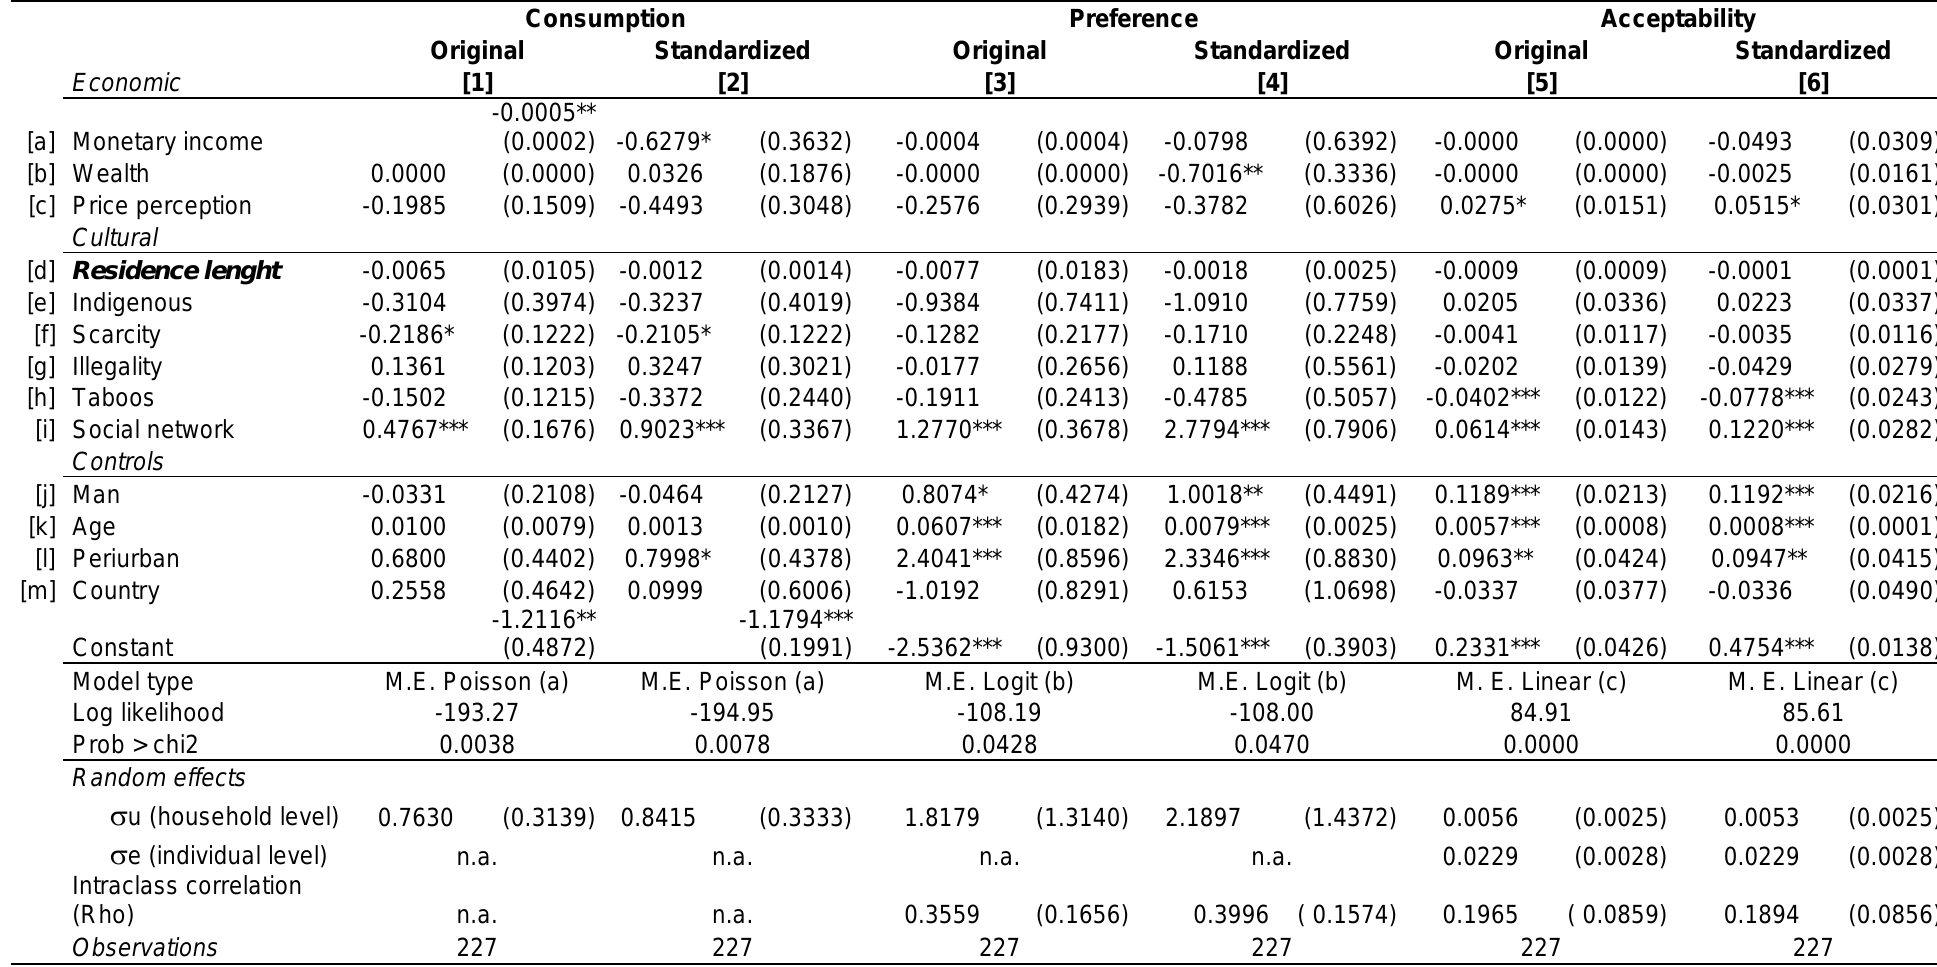
Appendix 1 . Results of mixed-effects regressions of the association between economic and cultural indicators with bushmeat consumption and preference with variable residence length included (n =